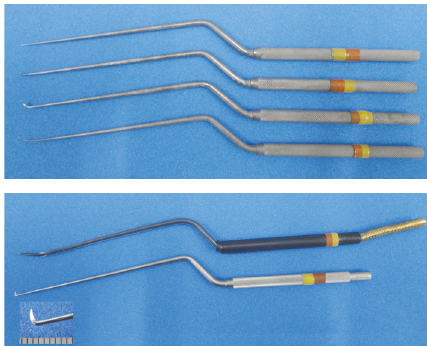
Figure 1: The microdissectors, malleable cauterization microprobe, and microknife.